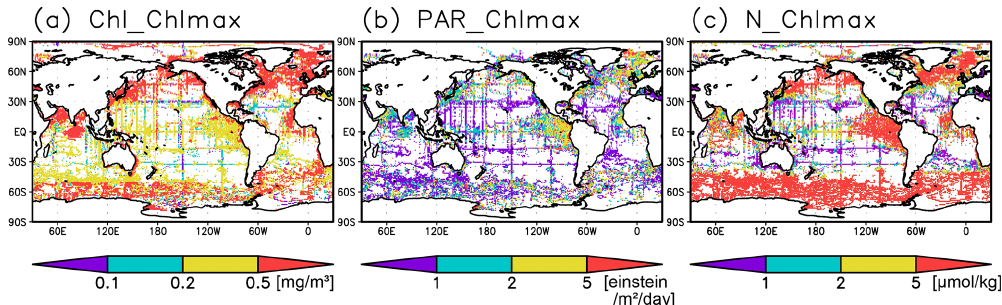
Figure 6. (a) Chlorophyll a (Chl a ) concentrations, (b) photosynthetically available radiation, and (c) nitrate concentrations at the Chl a maximum depth.